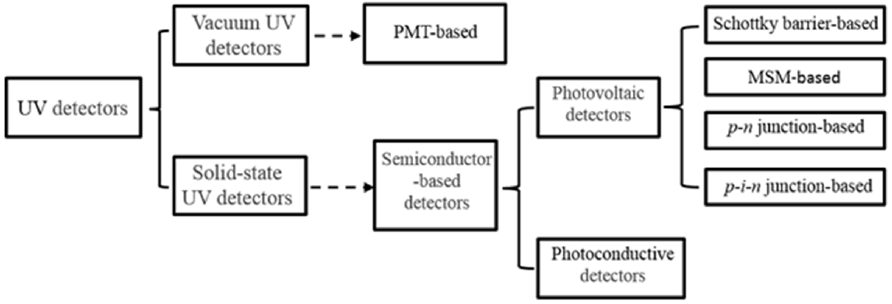
Figure 2. Classification of UV detectors.